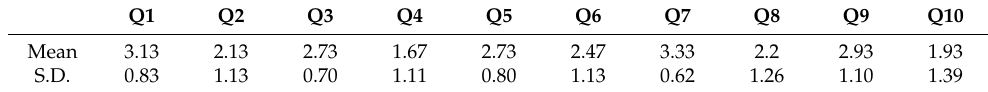
Table 4. SUS items’ mean score contribution (weighted: range 0–4): target group. Q1